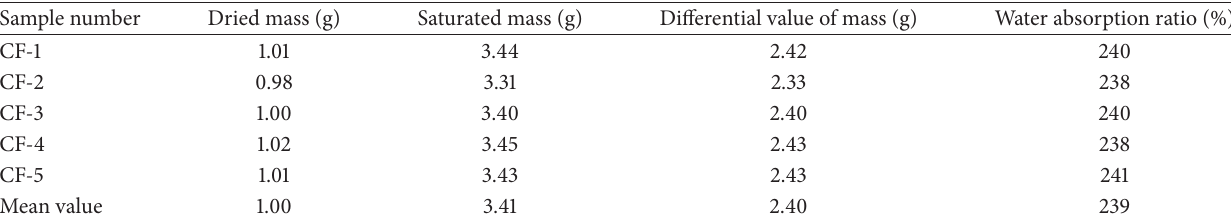
Table 2: Water absorption ratio of cellulose fibers.